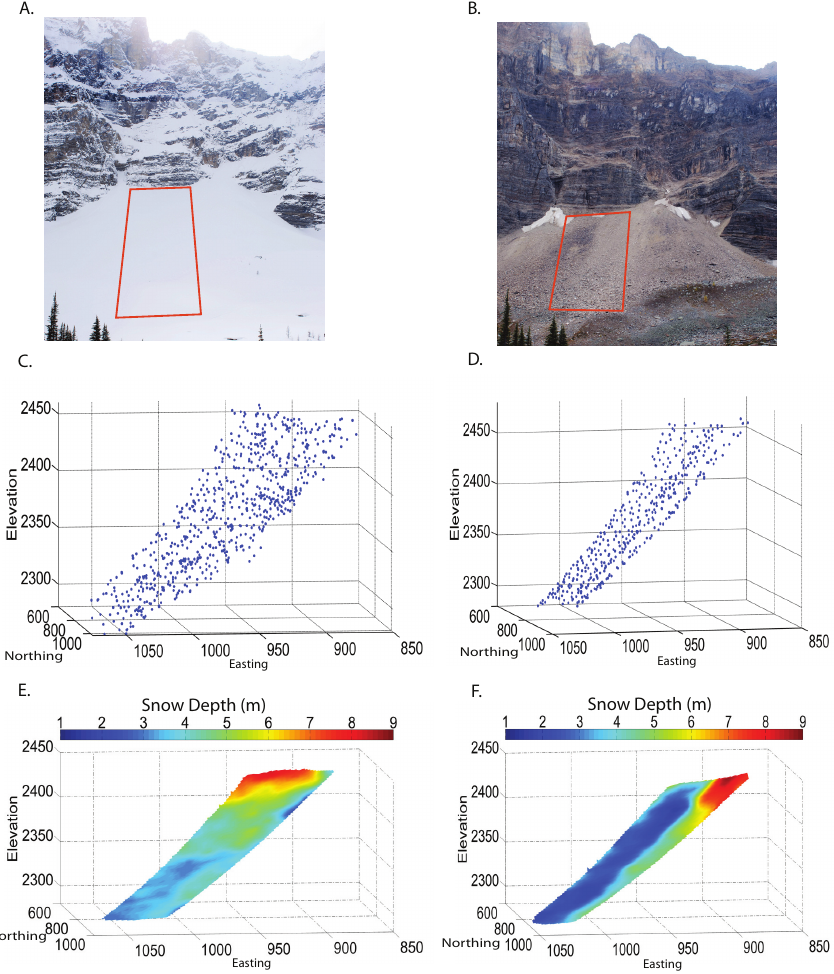
Fig. 7. Lower talus slope (A) snow covered (28 April 2009), (B) snow-free (30 September 2009), (C) distribution of laser points (20 April 2008), (D) distribution of laser points (18 April 2009), (E) laser snow depth (2008), (F) laser snow depth